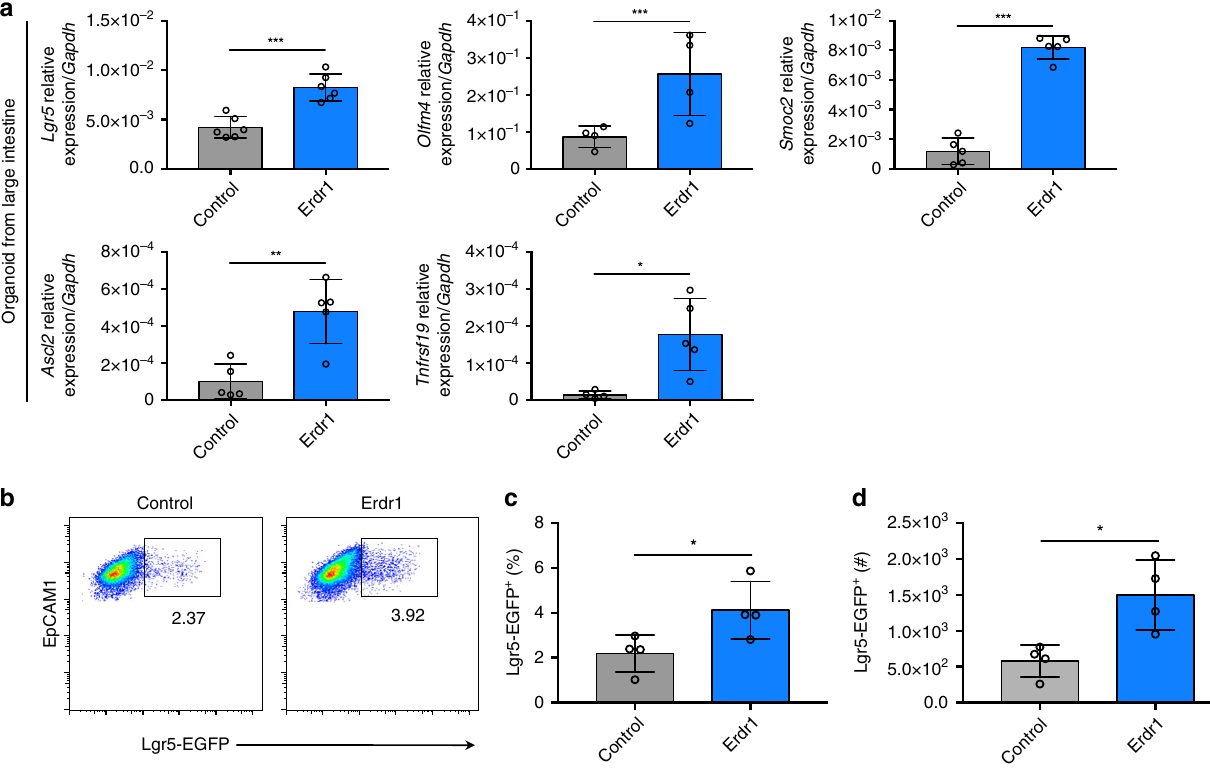
Fig. 4 Erdr1 induces ISC signature gene expression and Lgr5 + ISCs. a Expression of stem cell signature genes ( Lgr5 , Olmf4 , Smoc2 , Ascl2 , Tnfrsf19 ) in LI organoids from SPF mice cultured ±Erdr1 for 6 days. n = 4 ( Olfm4 ), n = 5 ( Smoc2 , Ascl2 , Tnfrsf19 ), n = 6 ( Lgr5 ); representative of three experiments. b – d Frequency and cell numbers of Lgr5-EGFP + cells (live cells, EpCAM1 + , EGFP + ) in SI organoids cultured ±Erdr1 for 6 days. n = 4; representative of